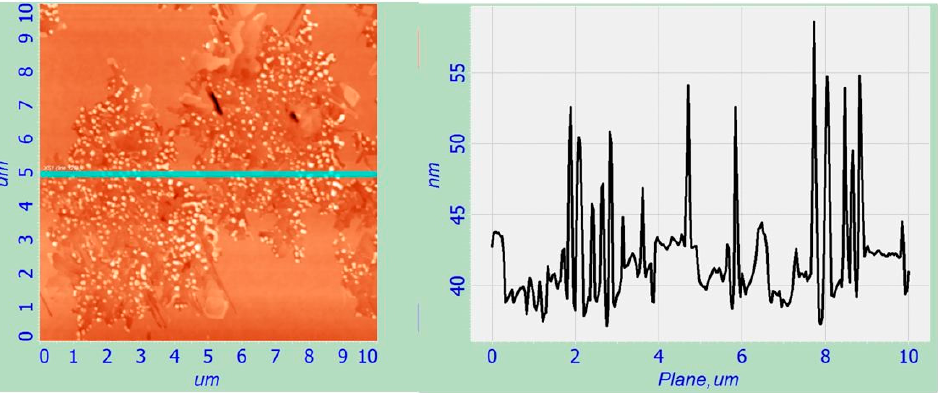
Figure 12. AFM surface image and the surface profile taken in the line for region